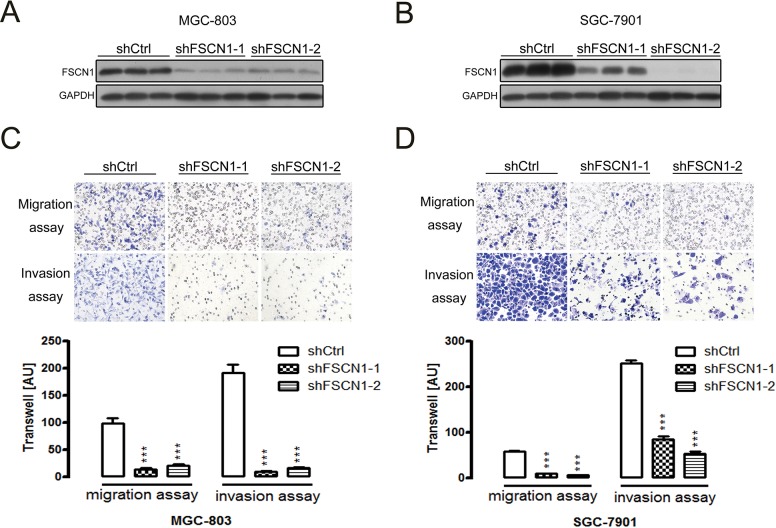
Migration and invasion efficiencies of gastric cancer cell lines stably expressing lacZ shRNA (control) and two different FSCN1 shRNAs.(A and B) Western blotting was used to measure the relative expression of FSCN1 protein in MGC-803 (A) and SGC-7901 (B) cells stably expressing lacZ shRNA and two different FSCN1 shRNAs. (C and D) ShFSCN1 MGC-803 (C) or SGC-7901 (D) cells exhibited decreased migration and invasion ability compared to shCtrl MGC-803 or SGC-7901 cells. Representative images (top) and cell counts (bottom) are shown. AU: arbitrary unit. The data are presented as the mean±SD of three individual experiments (***P<0.001).